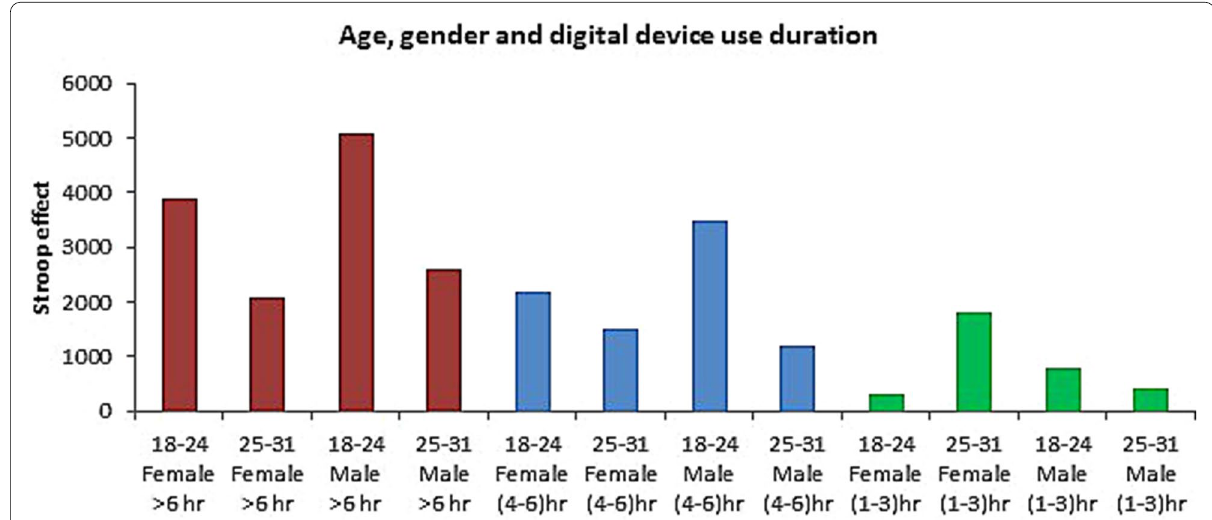
Fig. 3 Changes of Stroop effect in different age, gender and digital device use